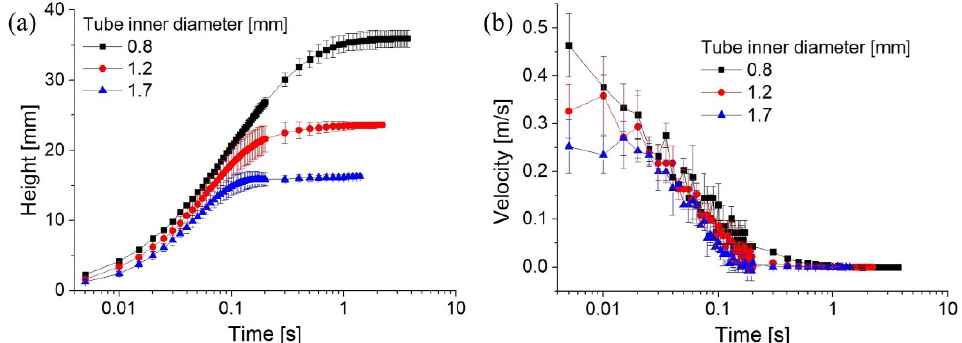
Figure 7. Effect of tube diameter (2 r = 0.8, 1.2, and 1.7 mm) on capillary rise dynamics of DW. ( a ) height and ( b ) velocity.